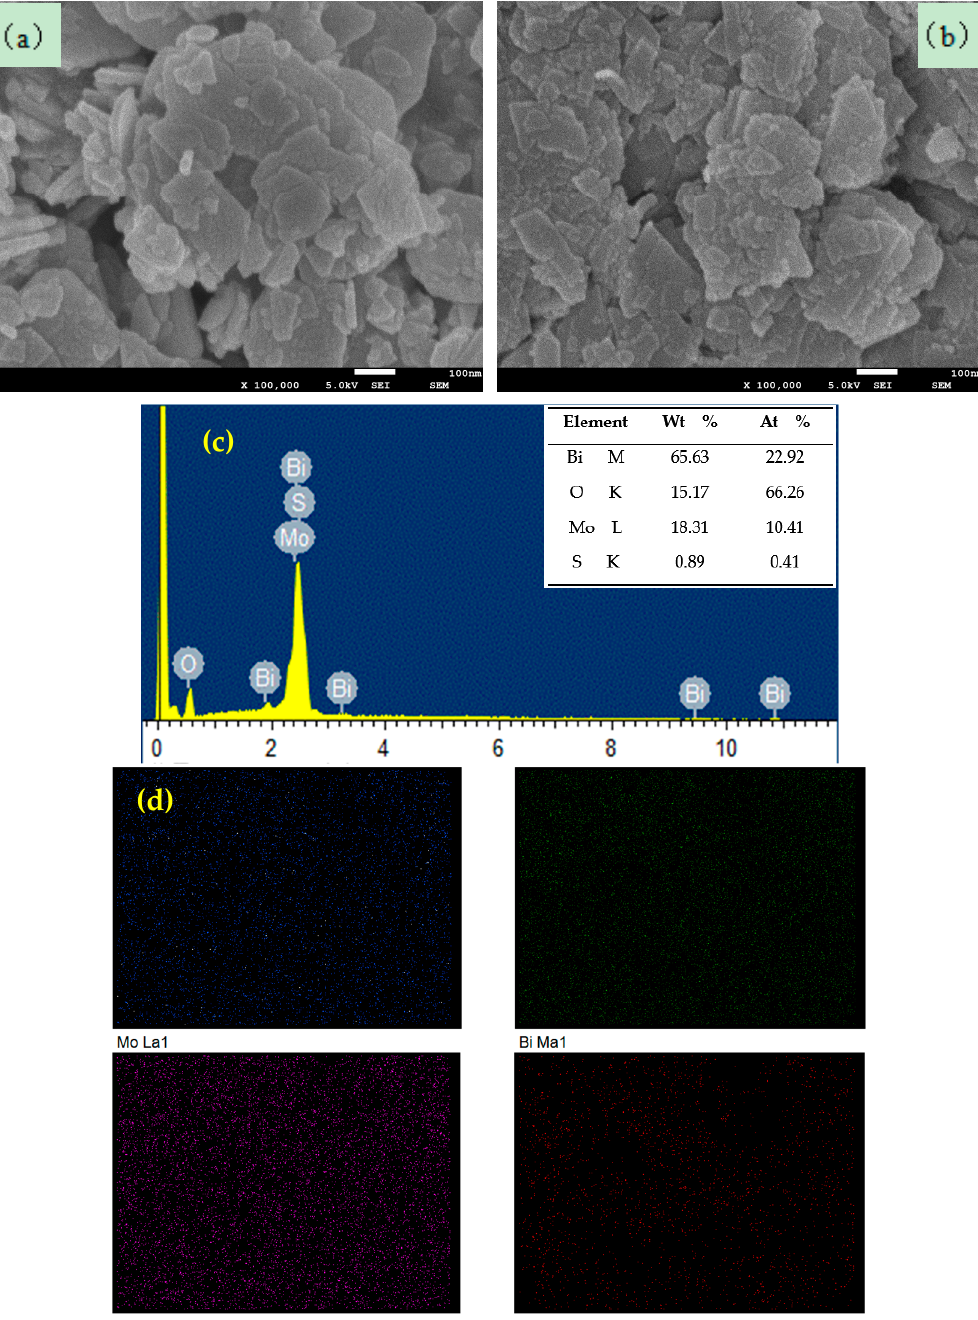
Figure 7. ( a ) Scanning electron microscope (SEM) image of Bi 2 MoO 6 , ( b ) SEM image of 1% S-doped Bi 2 MoO 6 , ( c ) energy dispersive X-ray spectroscopy (EDX) spectrum of 1% S-doped Bi 2 MoO 6 , and ( d ) element mapping images of 1% S-doped Bi 2 MoO 6 .